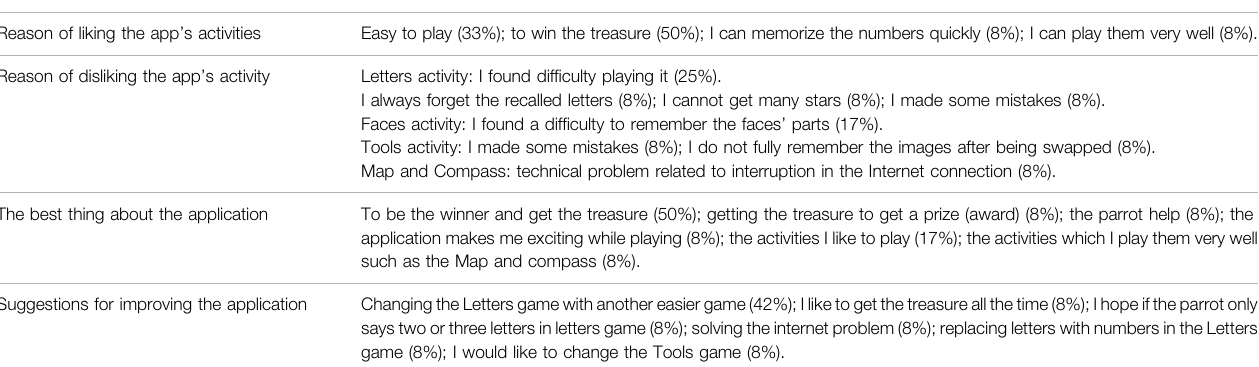
Interview (children ’ s